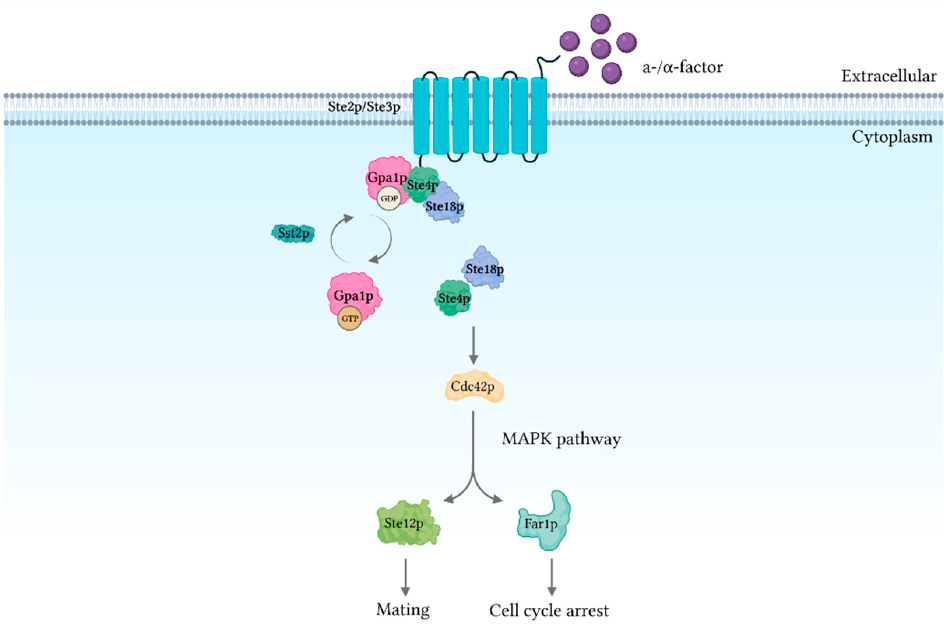
Figure 8. Schematic representation of the pheromone signaling pathway in S. cerevisiae . Pheromone signaling relies on the two sensors Ste2p and Ste3p that bind a- and α -factor. The signal is transported to the GPCR consisting of the G α protein Gpa1p and the βγ subunit Ste4p and Ste18p. Ste4p and Ste18p are released and subsequently stimulate Cdc42p, which results in activation of the mating MAP kinase cascade or in cell cycle arrest.